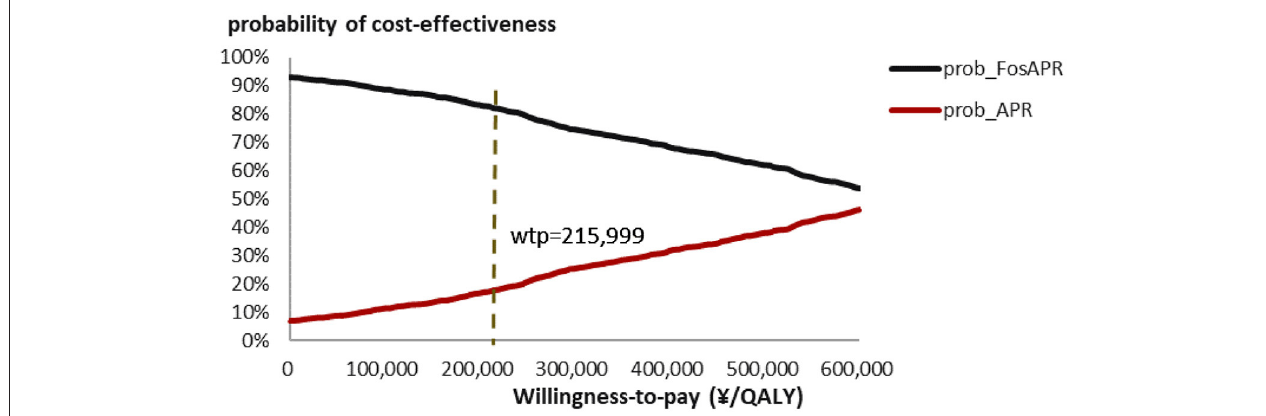
FIGURE 4 | Cost-effectiveness acceptability curve of FosAPR. WTP, willingness-to-pay; QALY, quality-adjusted life year; prob, probability of cost-effectiveness.